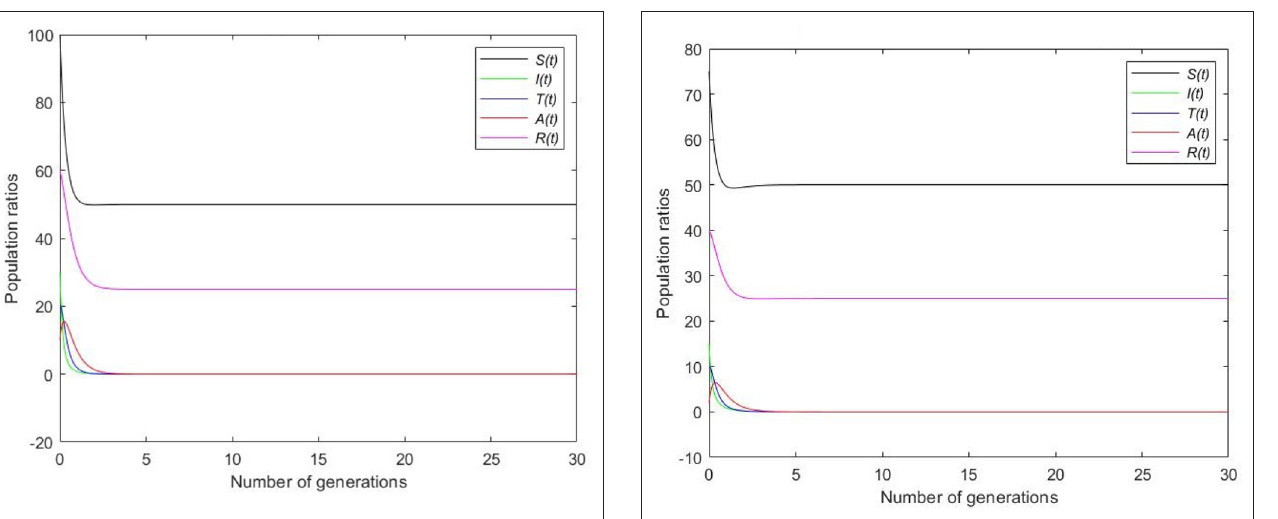
FIGURE 2 | Static simulation for disease-free equilibrium.